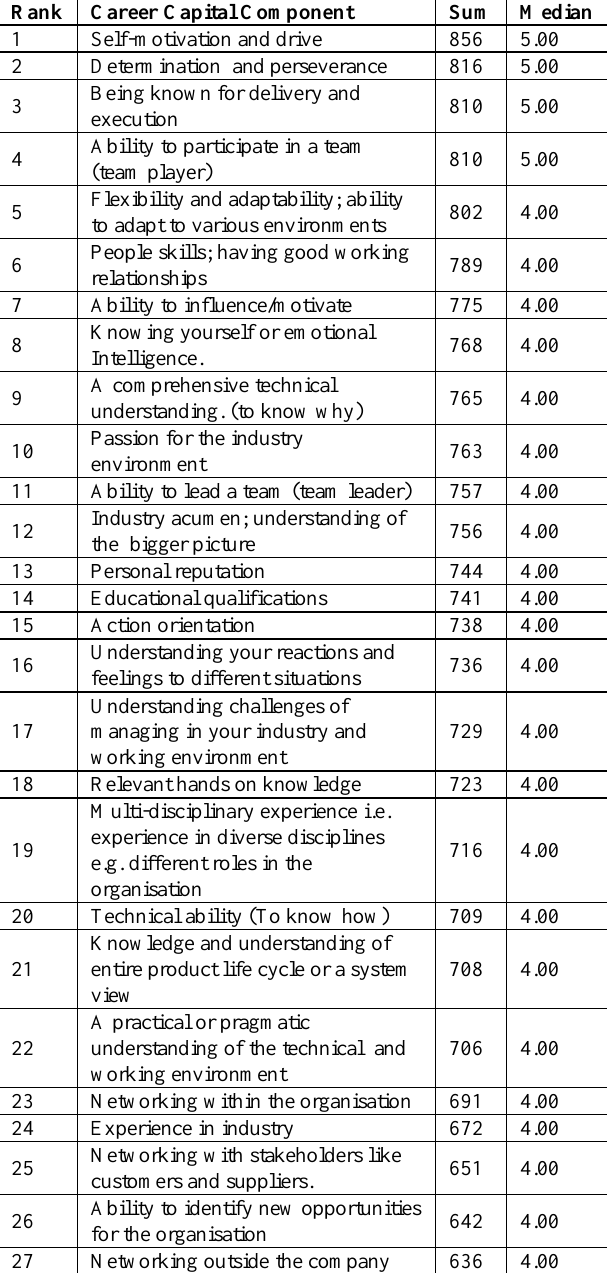
Table 2: Ranking of importance of career capital